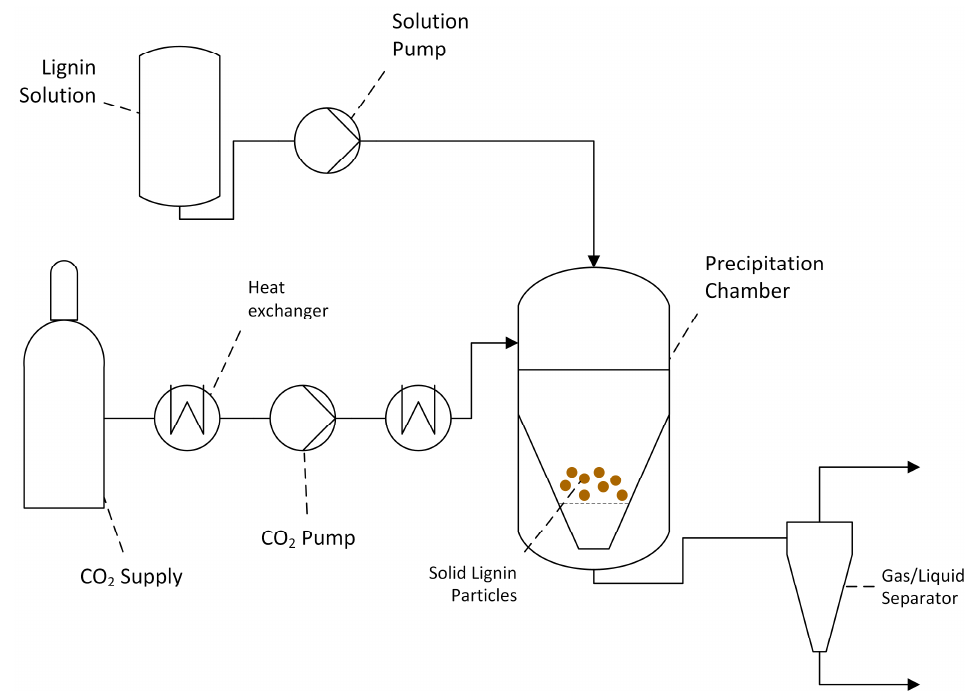
Figure 16. Schematic representation of a CO 2 precipitation setup.